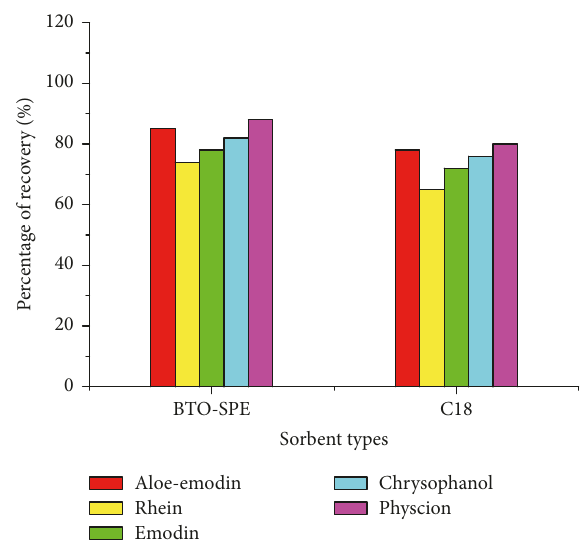
Figure 7: Comparison of the performance of BTO-SPE with C18 sorbent.